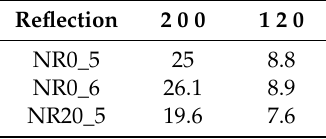
Table 3. Size of crystallites of strain-induced crystallization (SIC) in natural rubber (NR) samples at di ff erent stretch ratio in nm, estimated by the Scherrer